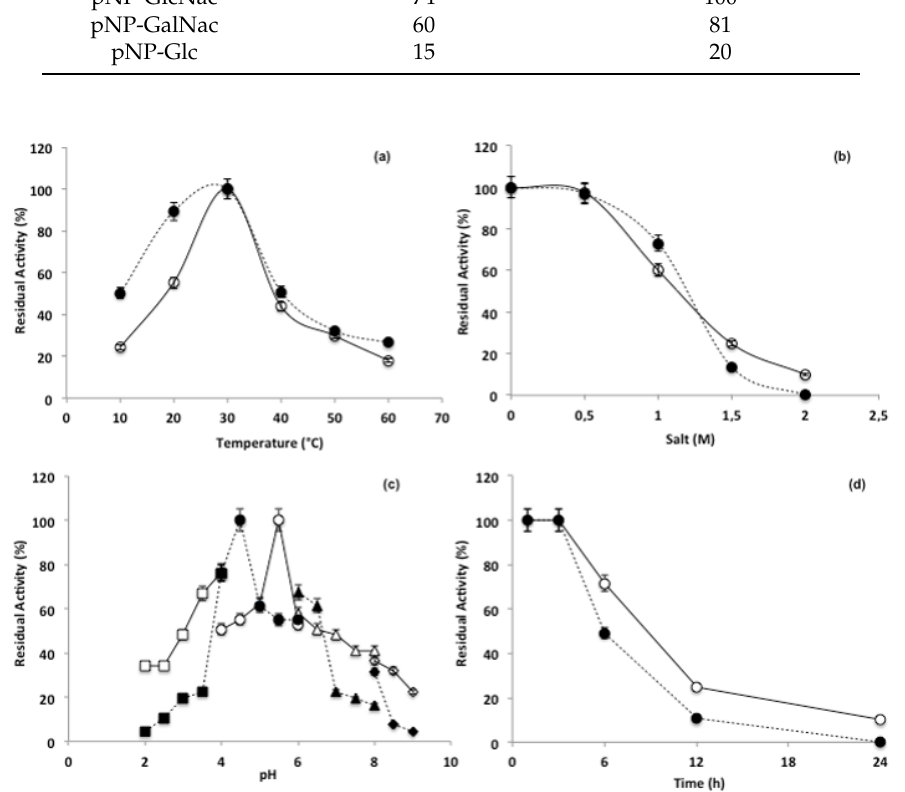
Figure 3. Characterization of optimum enzymatic conditions calculated as percentage of residual activity: ( a ) In relation to temperature (10 to 60 ◦ C); ( b ) in relation to sodium chloride concentrations (0 to 2 M); ( c ) in relation to pH (20 to 100); ( d ) in relation to stability (0 to 24 h) Continuous line represents β - N -acetylhexosaminidase activity in relation to pNP-GlNac; Dotted line represents β - N -acetylhexosaminidase activity in relation to pNP-GalNac.